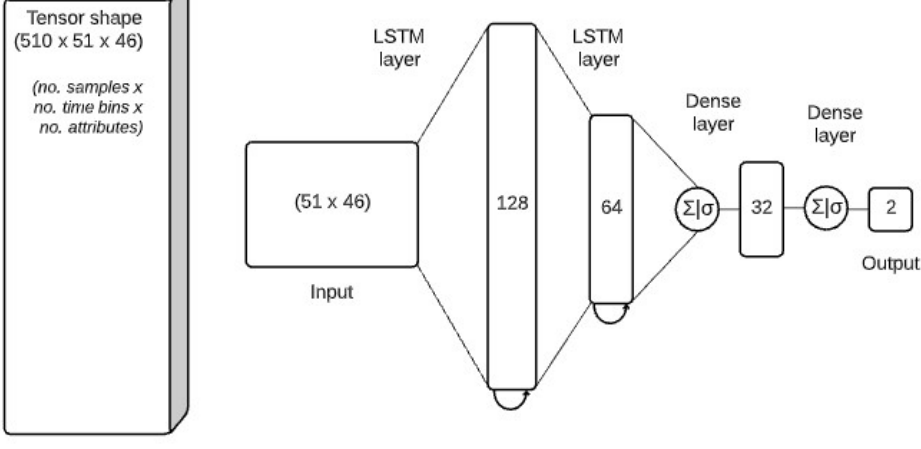
Figure 5. The Neural Network architecture for the stroke